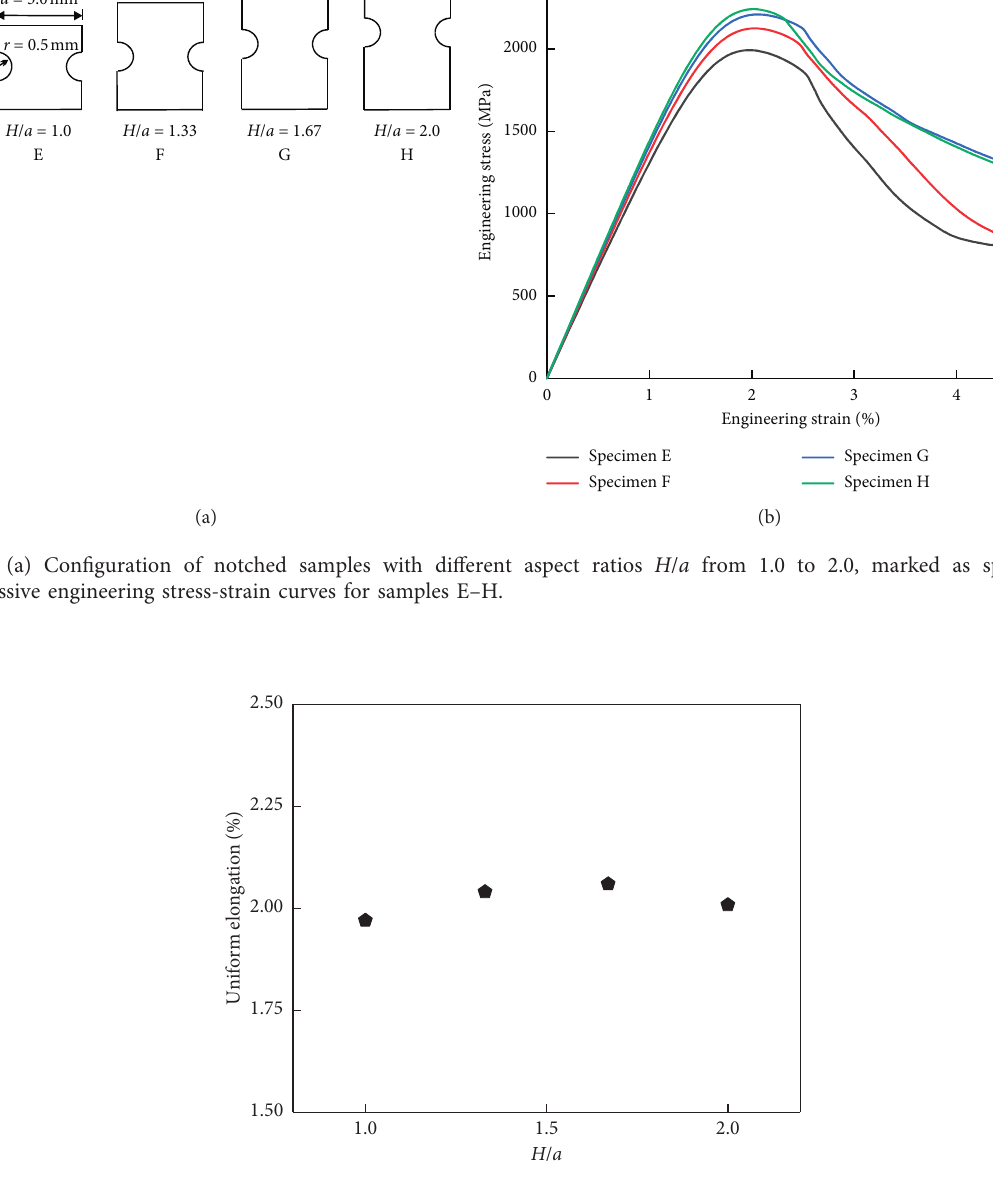
Figure 12: Dependence of uniform elongation for specimens with different aspect ratios H / a